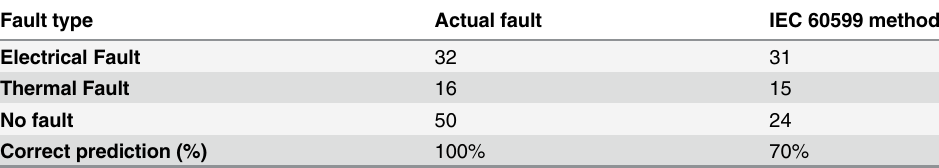
Table 2. Comparison of the indicated result by IEC 60599 with the actual result.